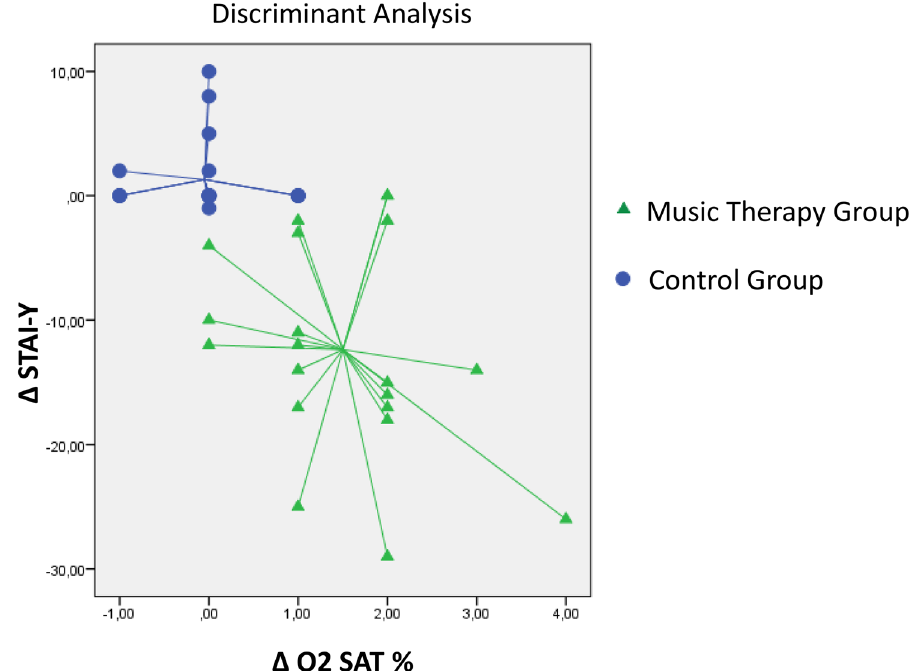
Figure 3. Discriminating analysis between the music therapy group and the control group. STAI-y State-Trait Anxiety Inventory—y form, TO time at the start of the session, T1 time during the session, T2 time at the end of the session, Δ STAI-Y: difference between the value of STAI-Y calculated at time T2 minus the value of Δ STAI-Y calculated at time T0; Δ O2 Sat%: difference between the value of O2 Sat calculated at time T2 minus the value of O2 Sat at time T0. The cross validate value able to discriminate the music therapy group compared to the control group starting from parameters Δ STAI-Y and Δ O2 Sat% was